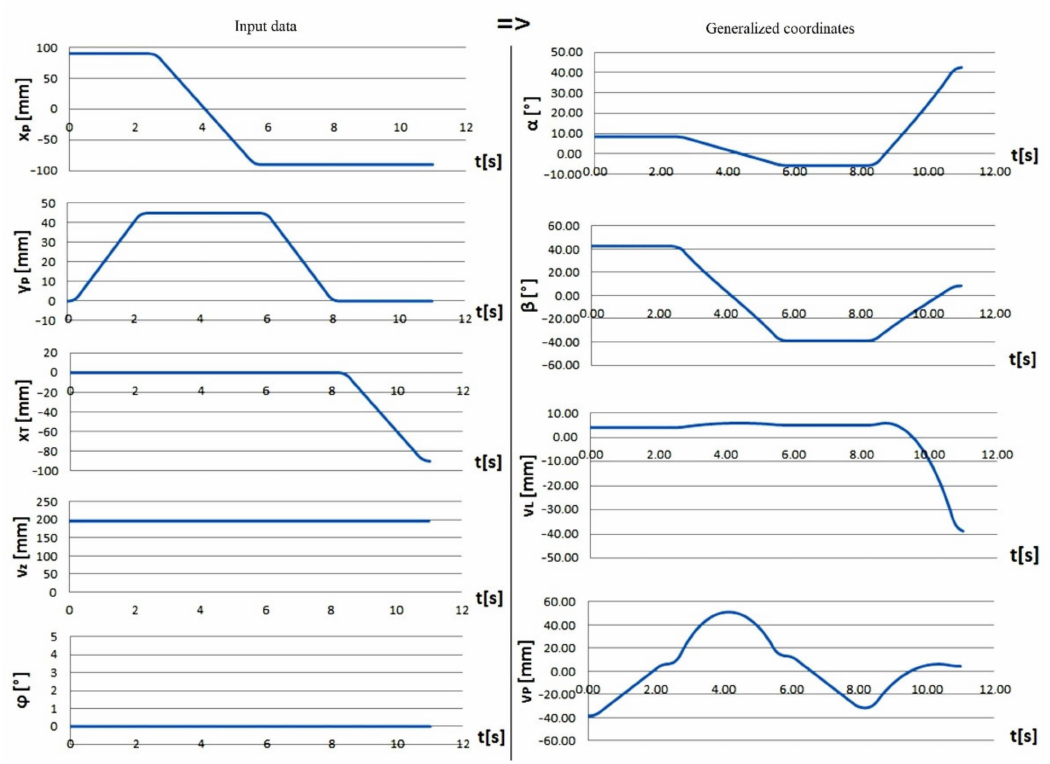
Figure 11. Recalculation of generalized coordinates based on input data for horizontal plane walking.